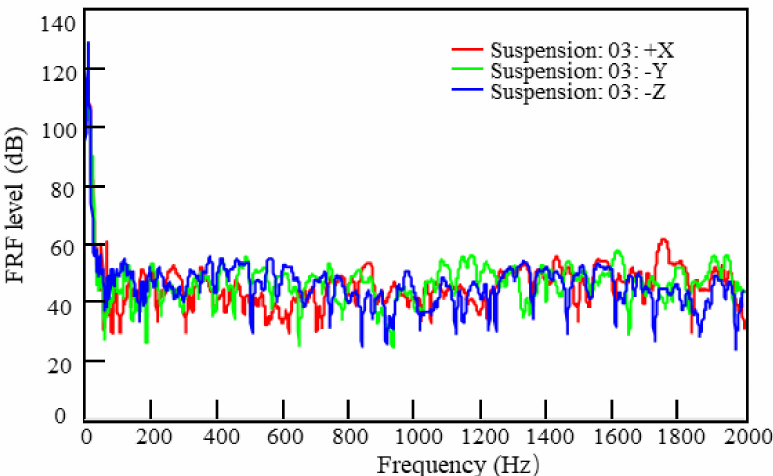
Figure 11. Transfer functions from the three directions of the front connection of the left rear suspension spring to the target point in the